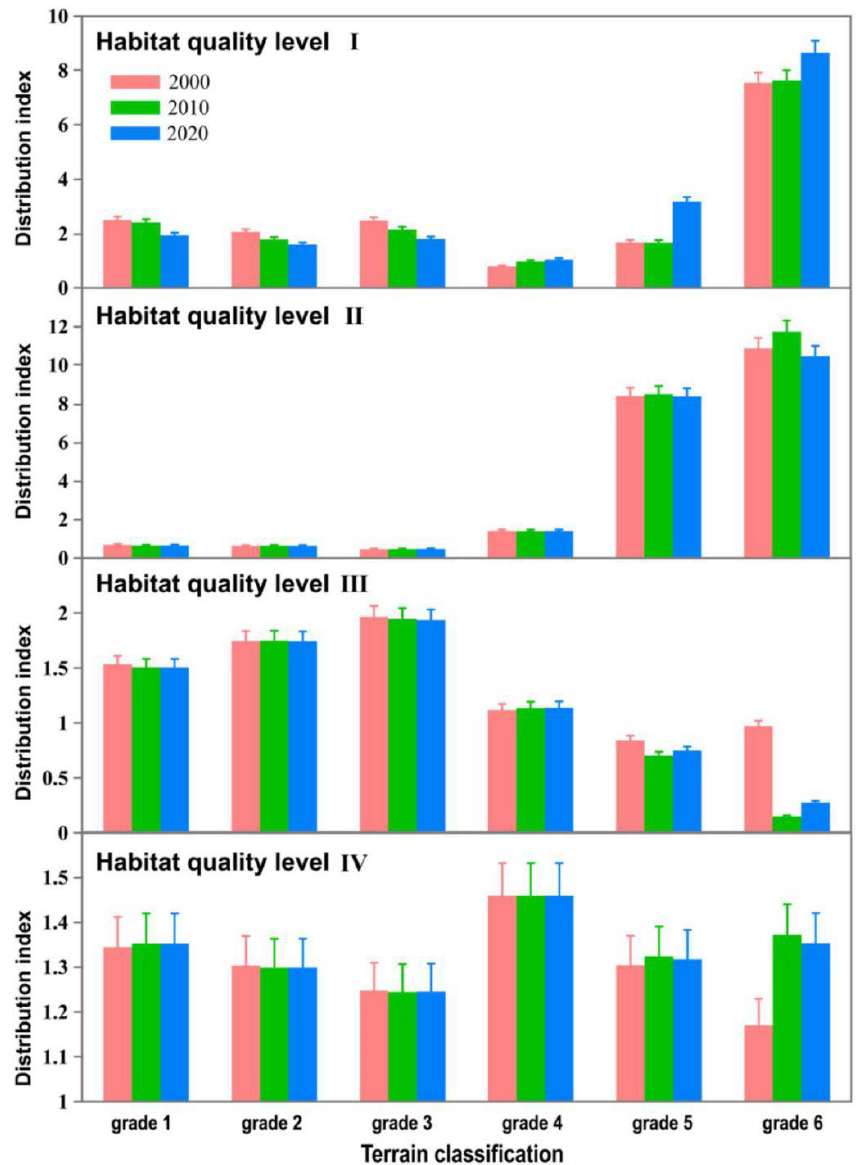
Figure 9. Topographic distribution index of different levels of habitat quality.